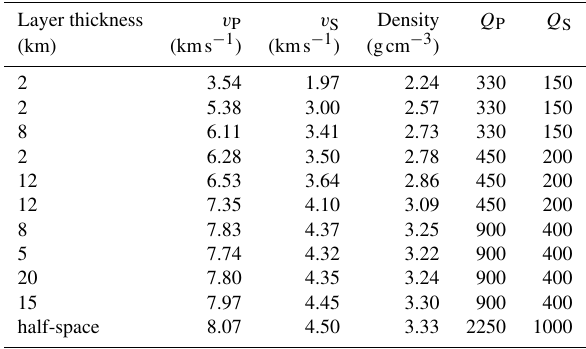
Table 1. Velocity model for moment tensor